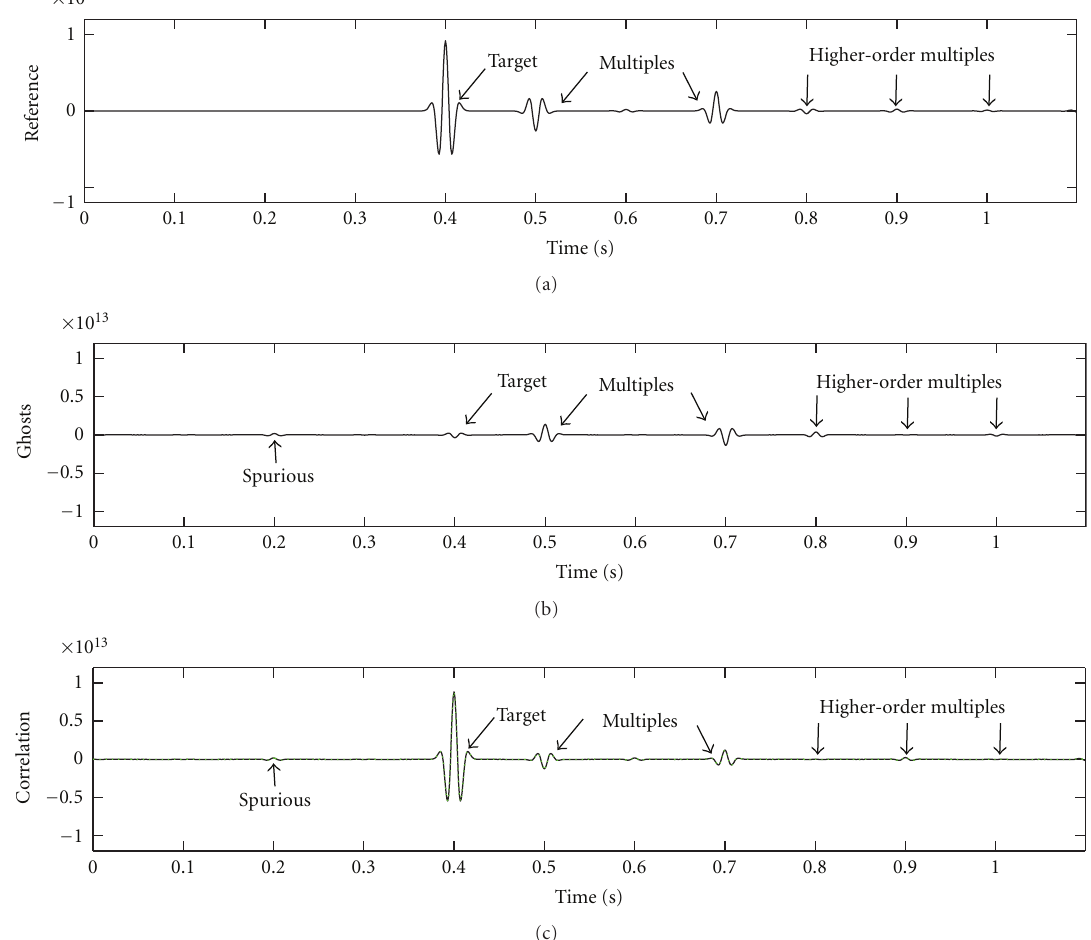
Figure 9: Cross-correlation of perturbed fields for model B: (a) reference response by placing an active source at the virtual source location + g E ; (c) correlation function C ptb (black) and the sum of reference response + ghosts (dashed x A ; (b) computed ghost terms g S ptb ptb